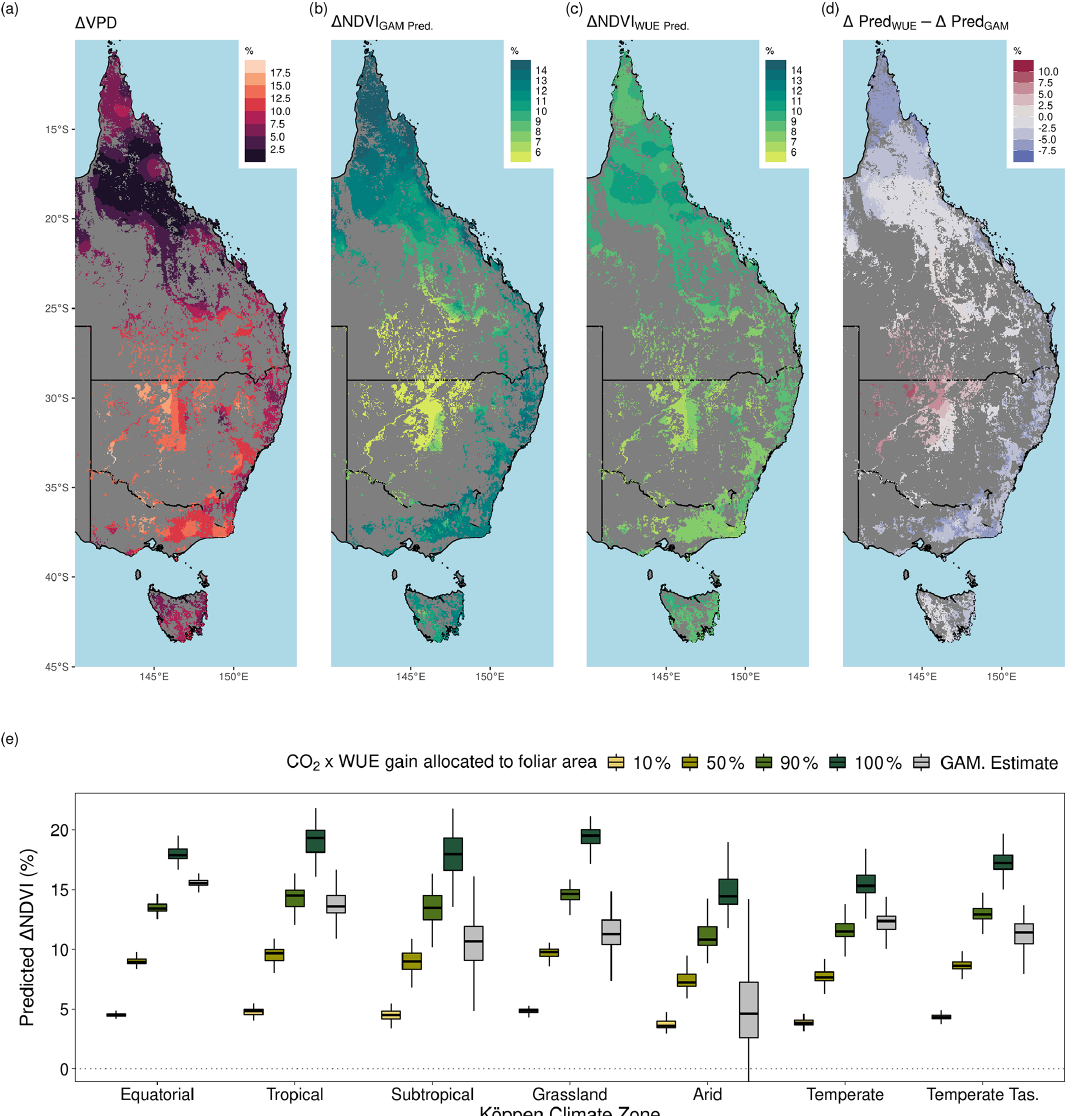
Figure 7. Long-term changes in vapor pressure deficit and comparison between the (cid:49) NDVI due to CO 2 and the expected CO 2 fertilization effect on foliar area due to gains in water use efficiency (WUE). (a) The relative increase in the annual mean of vapor pressure deficit (VPD) between 1982–2019. (b) The predicted relative increase in NDVI due to CO 2 (see “Methods”, Eq. 14) with a concurrent increase in VPD. (c) The relative expected increase in NDVI following the theoretical WUE prediction where 50% of the gain is allocated to foliar area (see “Methods”, Eq. 11). (d) The difference between the predictions of relative NDVI from the WUE model with 50% allocation and the GAM-estimated relative increase caused by CO 2 . Blue regions indicate where the GAM prediction was greater than the WUE prediction. (e) Boxplot of the expected relative NDVI% increase from WUE gains due to CO 2 fertilization depending upon differing levels of foliar allocation from the CO 2 benefit toward WUE and the GAM-estimated NDVI% increase due to CO 2 (see “Methods”, Eq. 11). The boxplot distribution of the Equatorial region appears collapsed because the Equatorial portion of the region is relatively small (a)